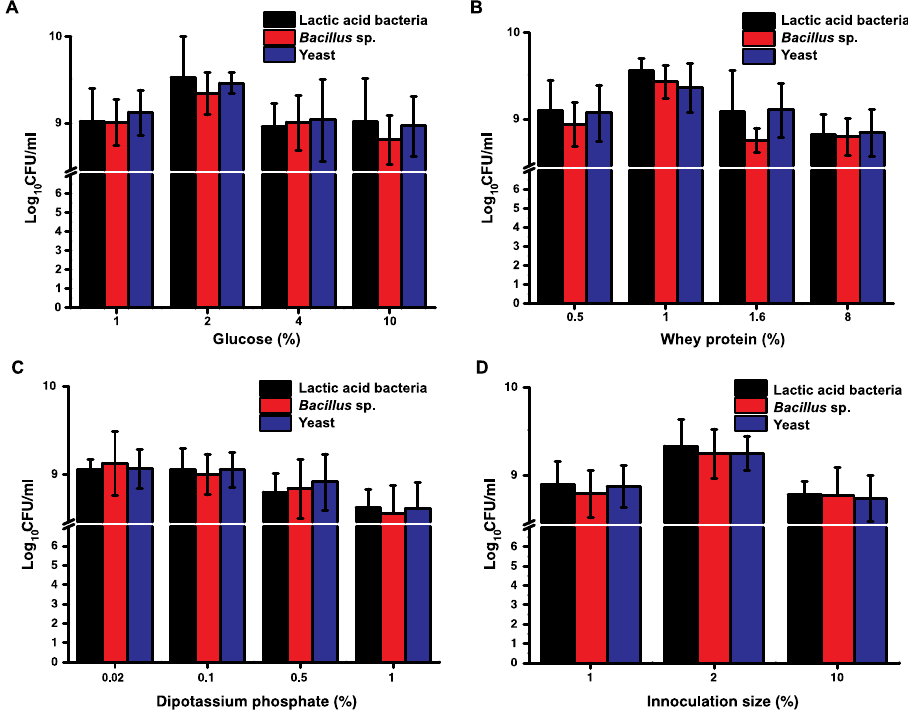
Figure 1. Proportion of lactic acid bacteria, Bacillus ssp., and yeast in kefir according to culture